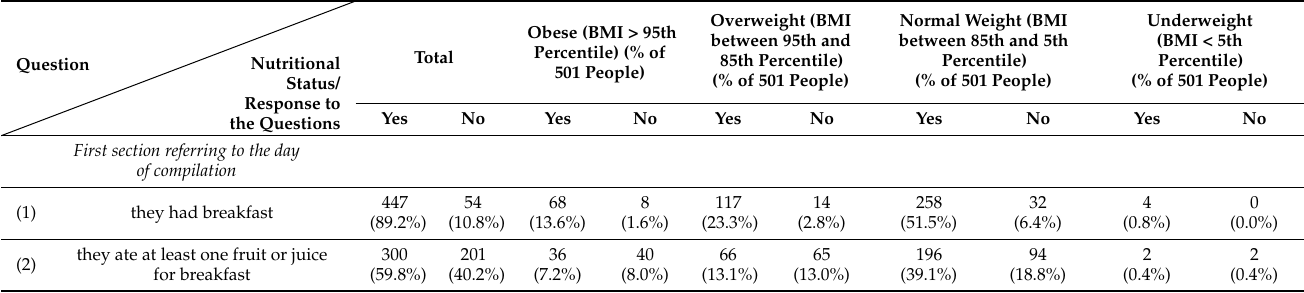
Table 2. Answers provided by students, stratified by nutritional